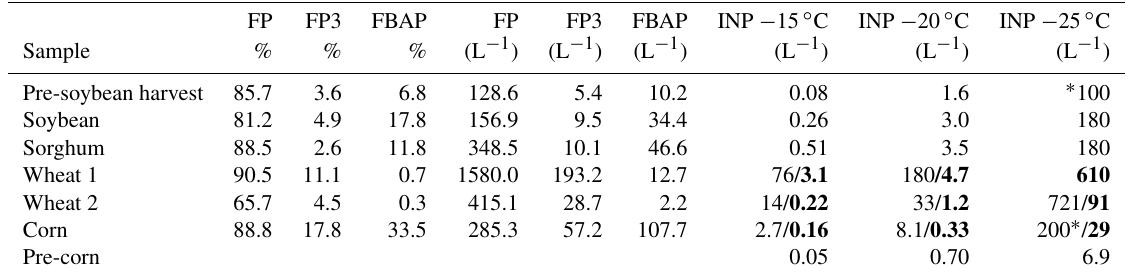
Table 2. WIBS data collected during the harvests showing the percentages and concentrations of fluorescent particles (FP), particles that flu- oresce in channel 1 (FP3), and fluorescent biological aerosol particles that fluoresce in two channels (FBAPs). INP concentrations measured with the IS with (bold) and without (normal) a cyclone are presented at − 15, − 20, and − 25 ◦ C. FP FP3 FBAP FP FP3 FBAP INP − 15 ◦ C INP − 20 ◦ C INP − 25 ◦ C Sample %